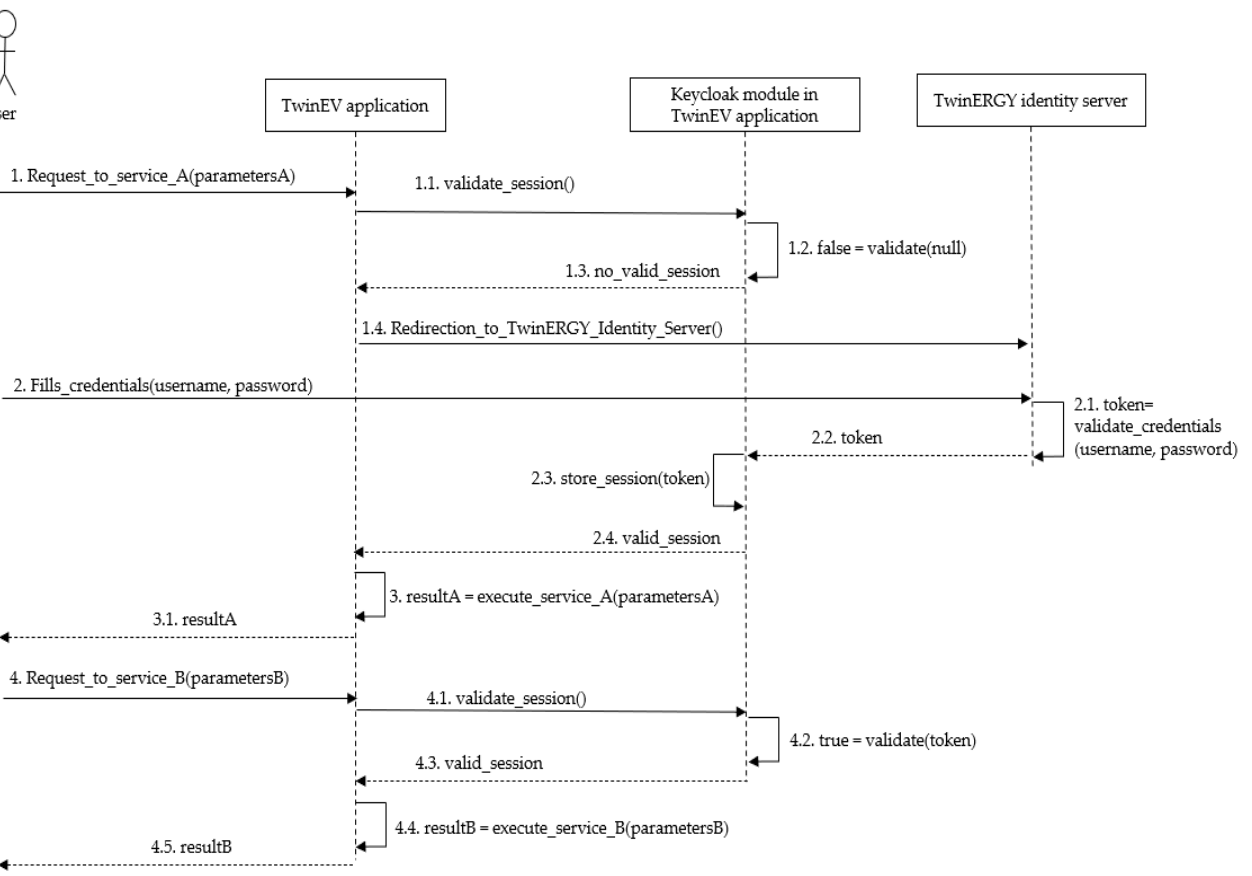
Figure 7. Flow of actions for validation of users.